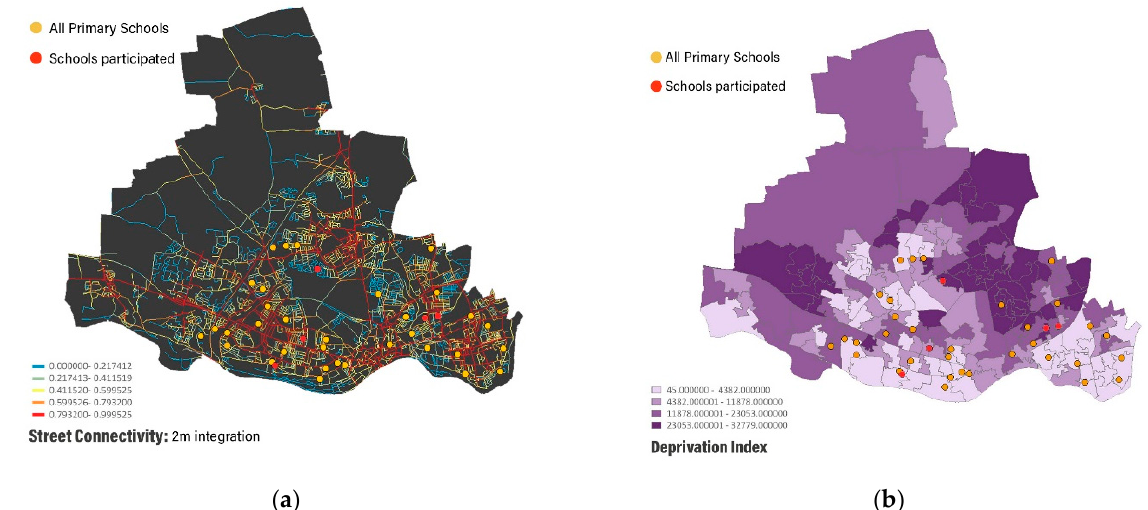
Figure 2. School selective criteria. ( a ) Street connectivity: 2 km integration; ( b ) deprivation rank.